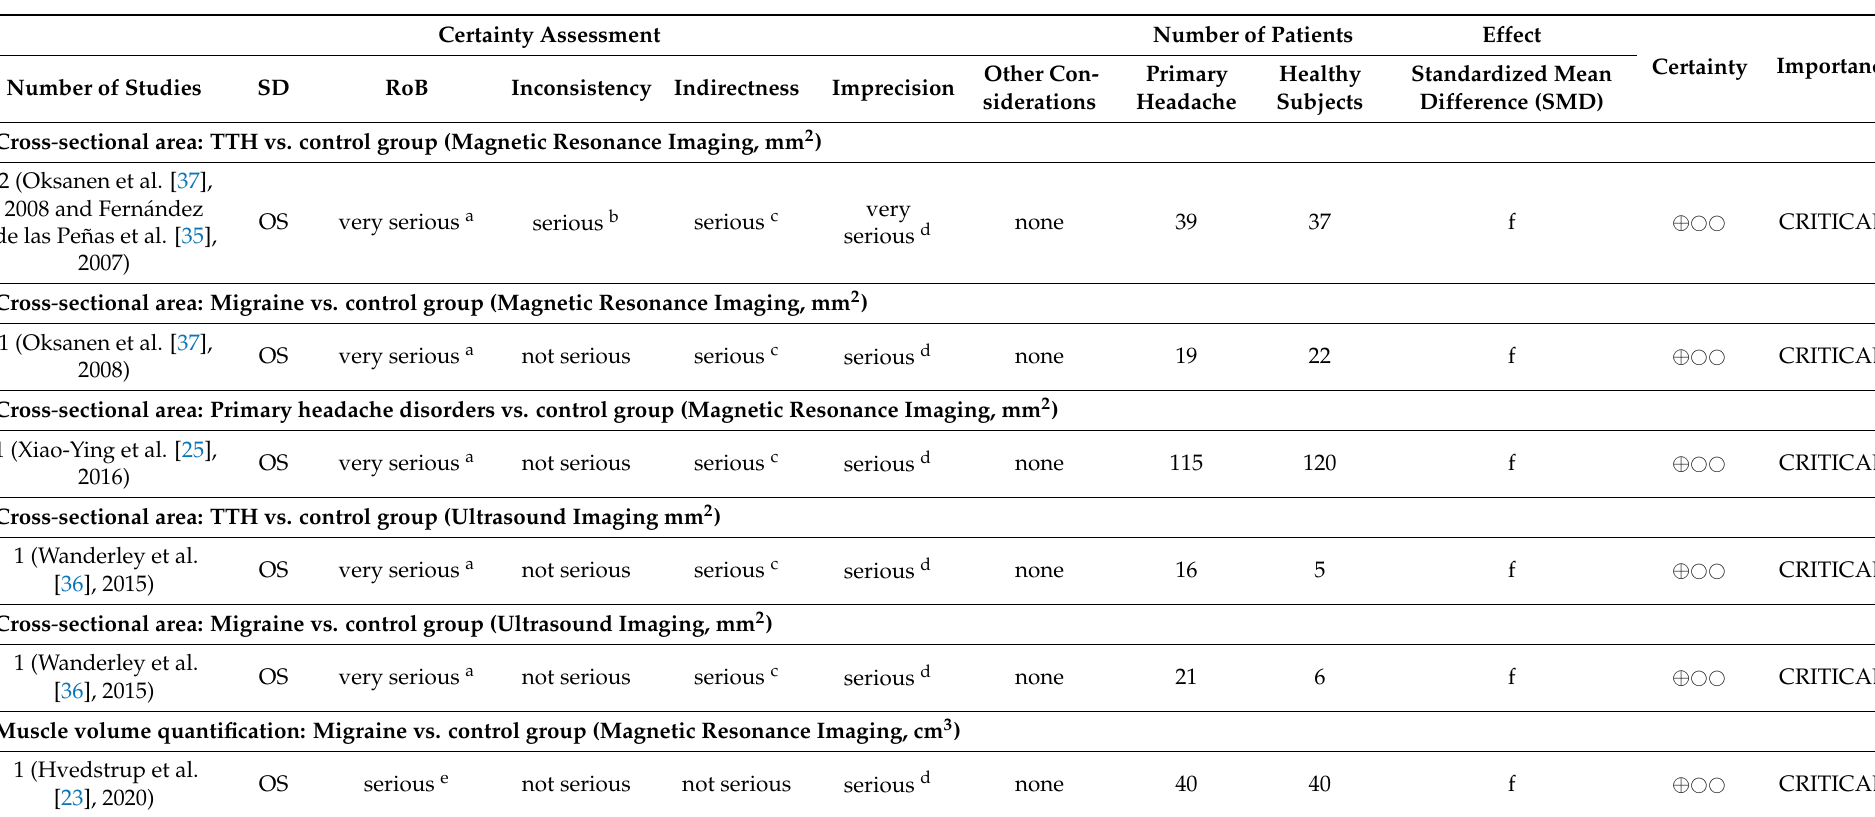
Table 3. GRADE. CI: confidence interval, SD: study design, RoB: Risk of bias, OS: observational studies and ⊕